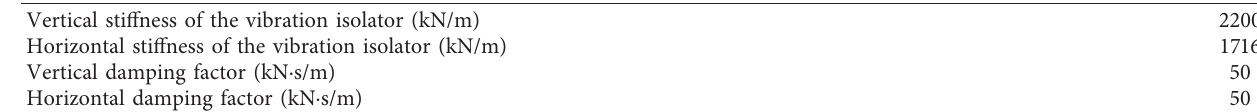
Table 12: Parameters of spring vibration isolators for concrete platform.